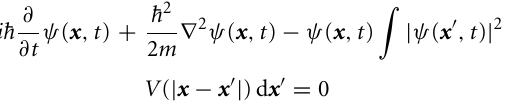
4 He at a sufficiently very low temperature) even though molecular viscosity is absent